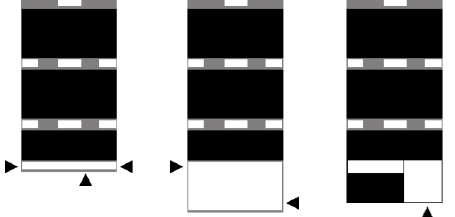
Figure 6. The mode chart of the three-step courtyards